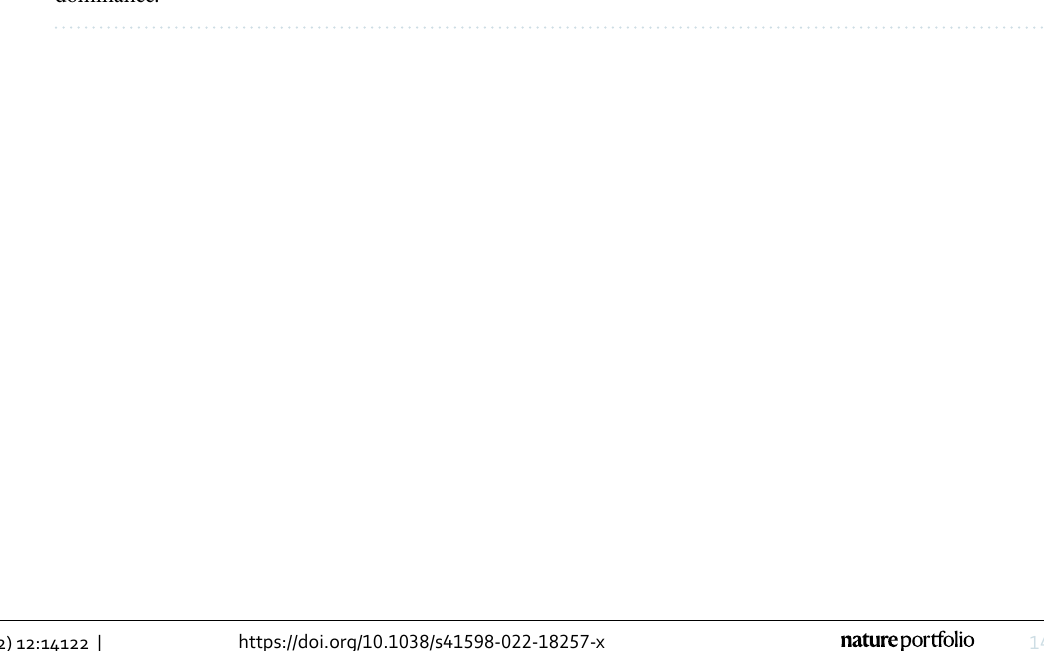
Figure 7. Overall class distribution after conversion to a two-class rating score for arousal, valence and